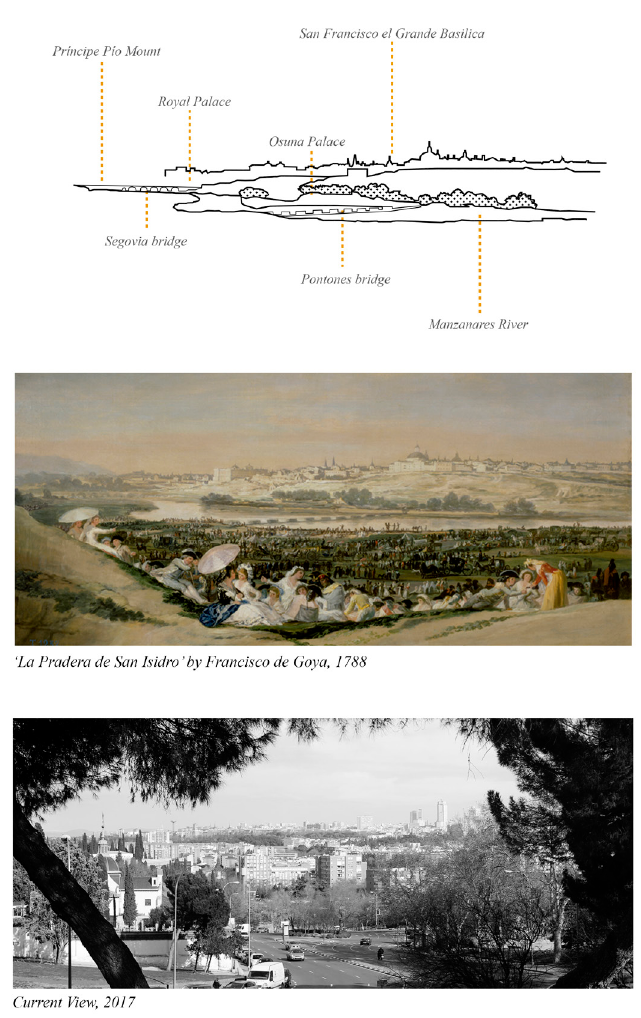
Figure 1: Interpretive drawing and current view from the natural lookout chosen by Francisco de Goya to depict Madrid in the eighteenth